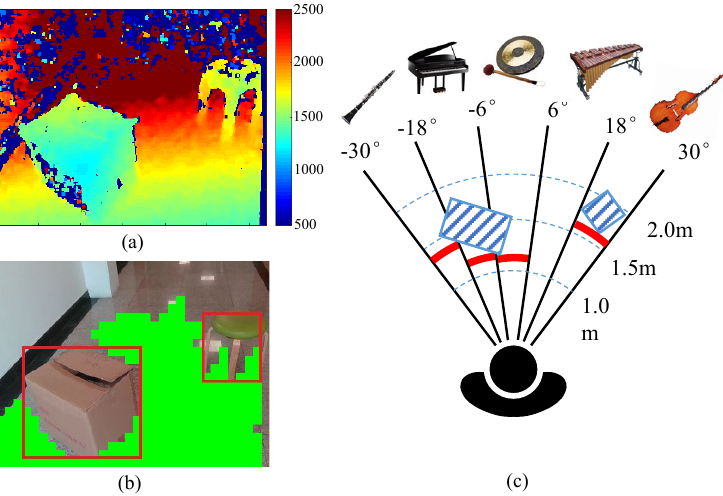
Figure 4. Obstacle sonification. ( a ) Raw depth image. ( b ) The results of ground and obstacle detection, where green masks represent the ground, and the detected obstacles are highlighted by red bounding boxes. ( c ) Sonification scheme, where obstacles are indicated by blue striped blocks and the obstacle distance of each section is indicated by red bold lines.